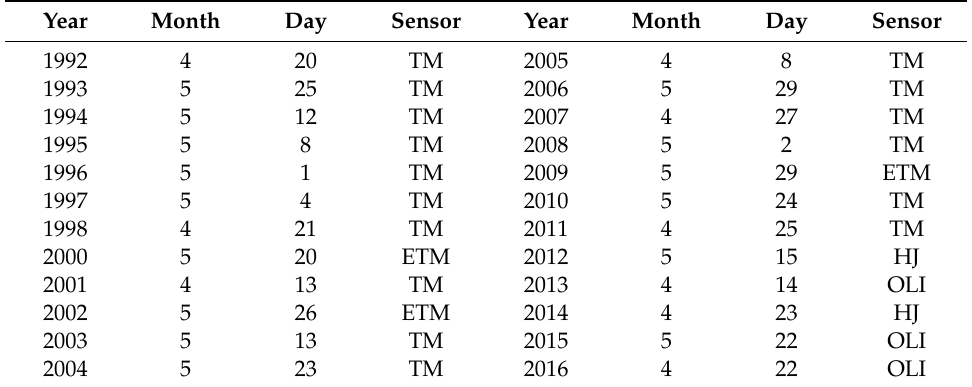
Table A1. Acquisition dates and sensors of satellite images used in this study for mapping pen aquaculture from 1992 to 2013.